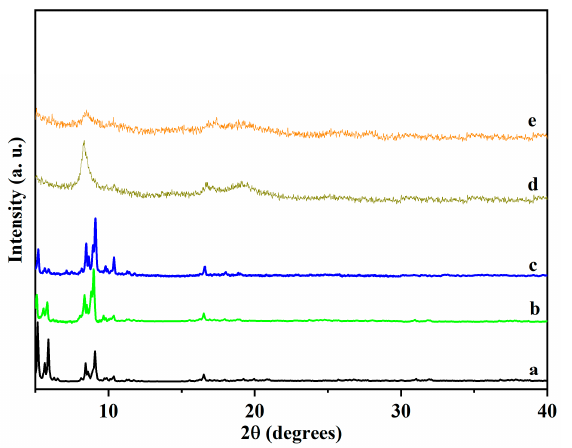
Figure 1. XRD patterns of ( a ) simulated MIL-101, ( b ) MA , ( c ) MAS , ( d ) MC , and ( e ) MCS .